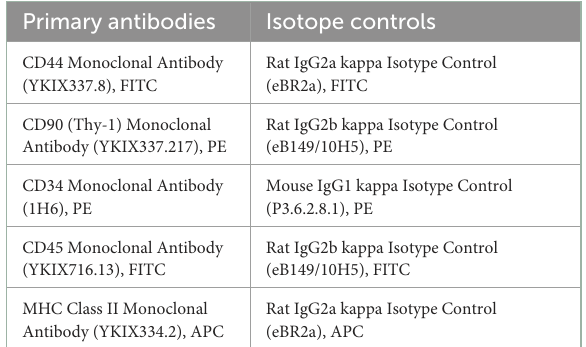
TABLE 1 Antibodies for immunophenotyping. Primary antibodies Isotope